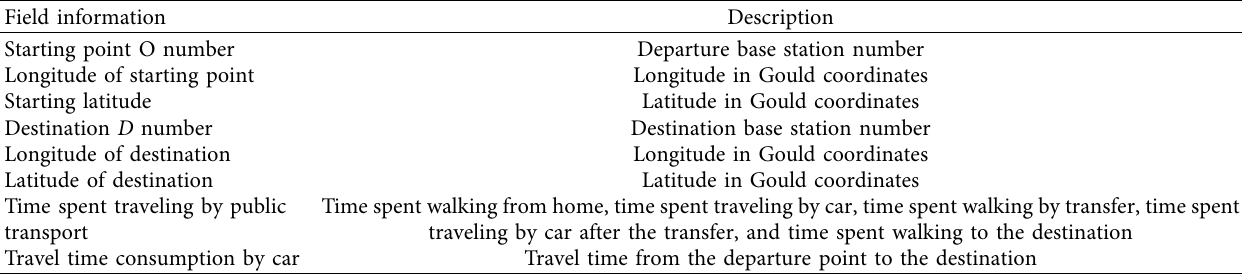
Table 5: Travel time consumption data based on Gaode Map